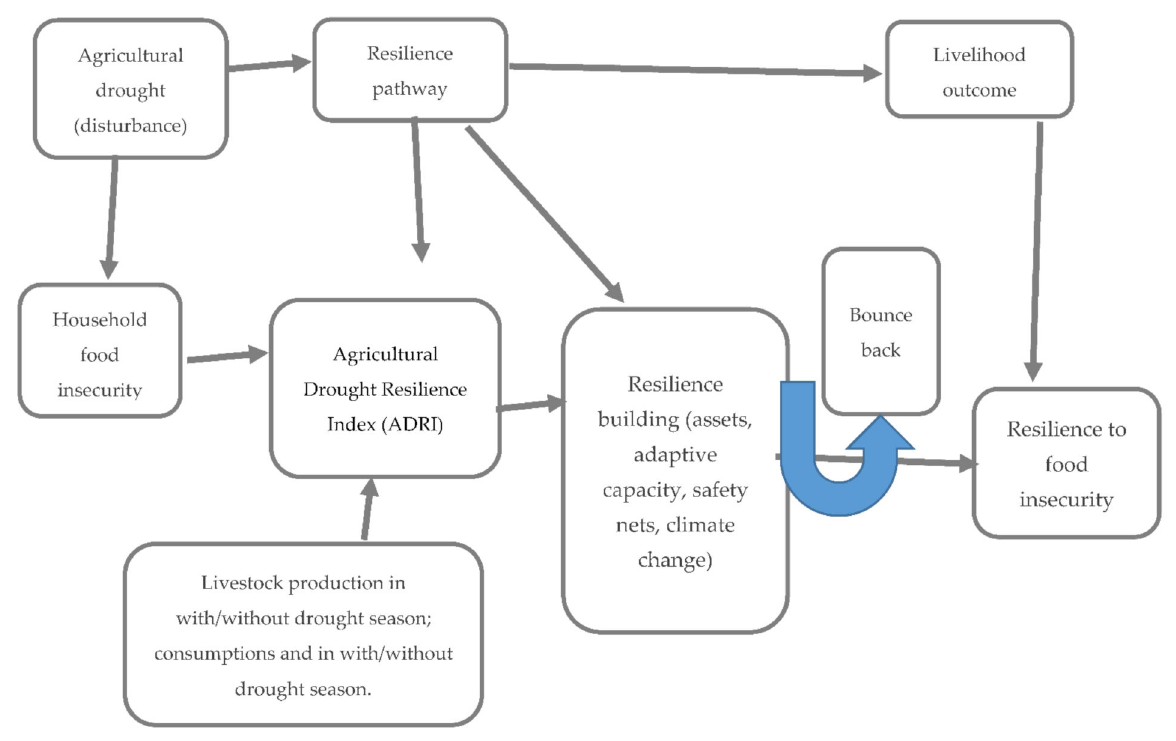
Figure 1. Conceptual framework of the study. Source: Authors’ work from observations of various